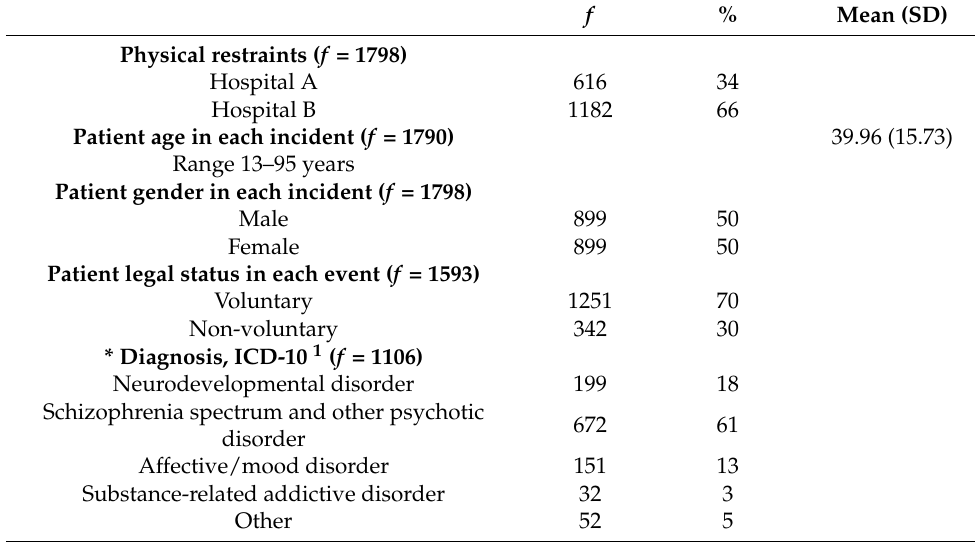
Table 2. Characteristics of the physical restraint events analysed.